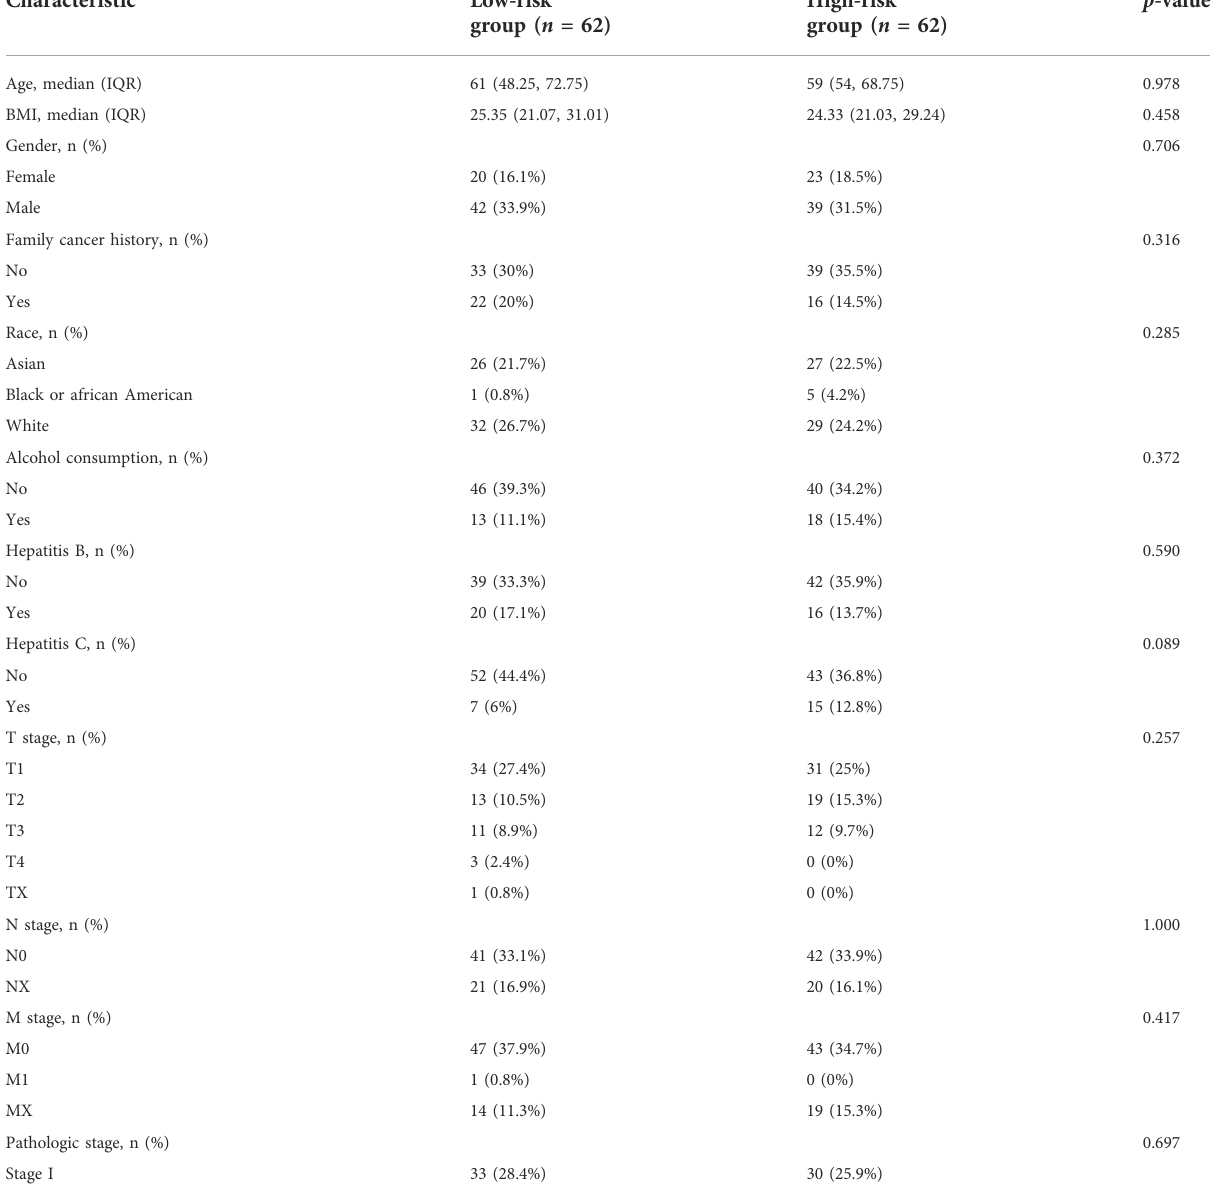
TABLE 3 Associations between the signature and patients ’ characteristics in the validation cohort.